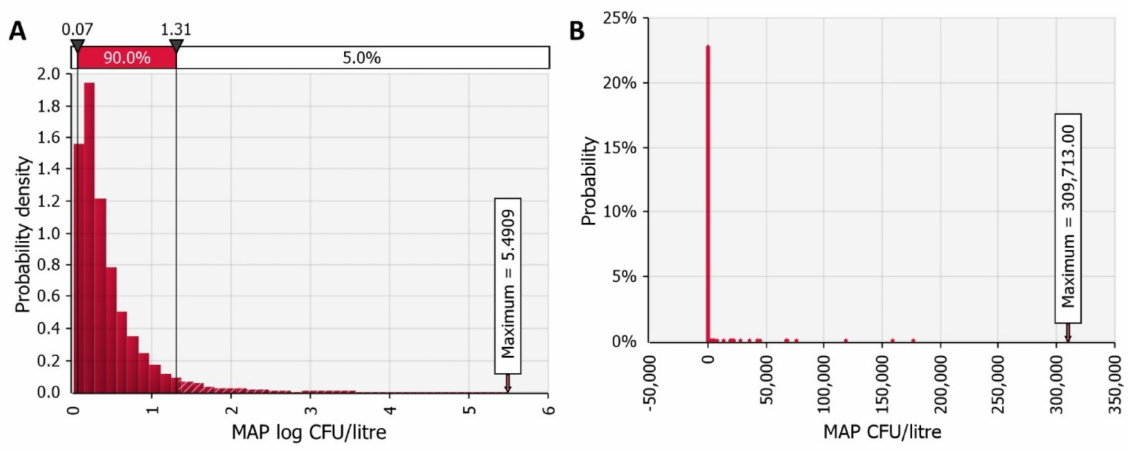
Figure 2. Mycobacterium avium subsp. paratuberculosis (MAP) contamination of raw milk in a MAP positive farm. ( A ) Probability density of MAP contamination of raw bulk tank milk. ( B ) Discrete probability of MAP contamination per litre of raw